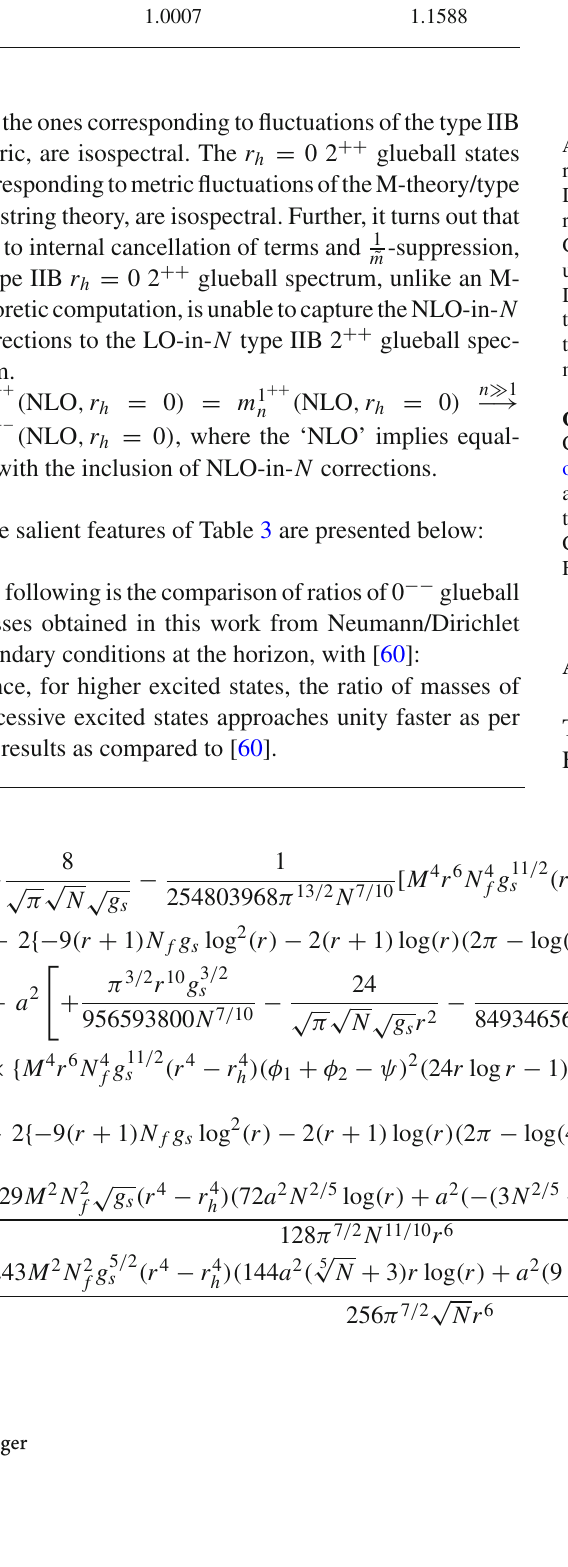
Table 4 Comparison of ratios of 0 −− glueball masses obtained from Neumann/Dirichlet boundary conditions at the horizon, with [60] Ratio Our results [60]’s results m ∗ 0 −− 1.0129 1.5311 m 0 −− 1.0033